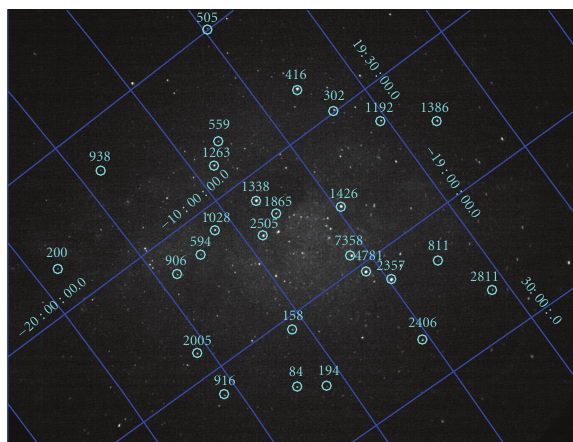
Figure 1: Image acquired by the TORTORA camera with an exposure time of 0.13 seconds. The selected stars are labeled using the identification number (id number) as tabulated in Tycho-2 catalogue. They have been chosen as reference stars to test the linearity and the homogeneity of the instrument (see text for more details). The center coordinates of the image are at the position: RA(J2000) = 18h : 37m : 05.28 s, DEC(J2000) = − 06 d : 29 (cid:2)